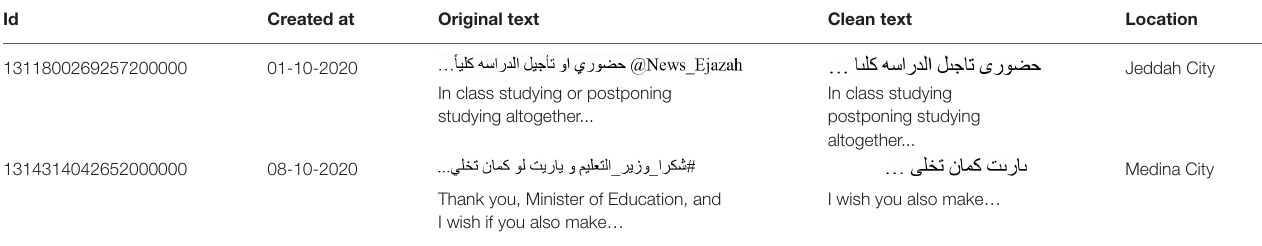
Table 2 | The output of JSON parser.